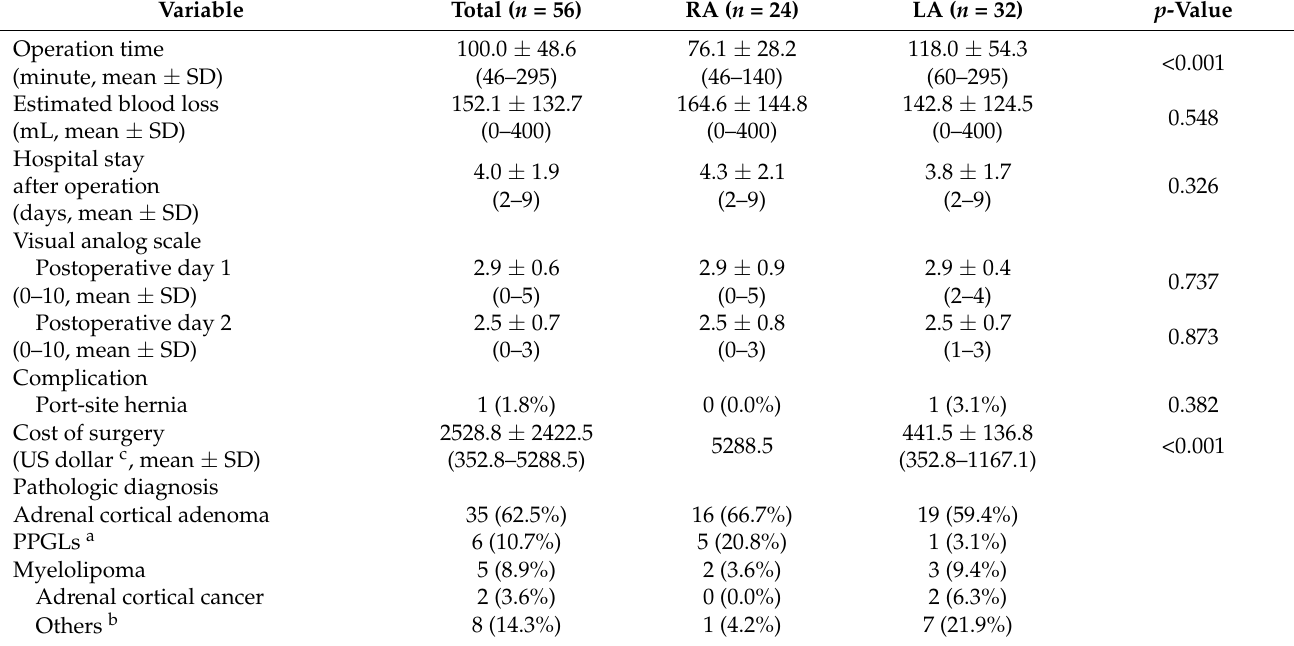
Table 2. Surgical and clinical outcomes of robotic adrenalectomy and laparoscopic